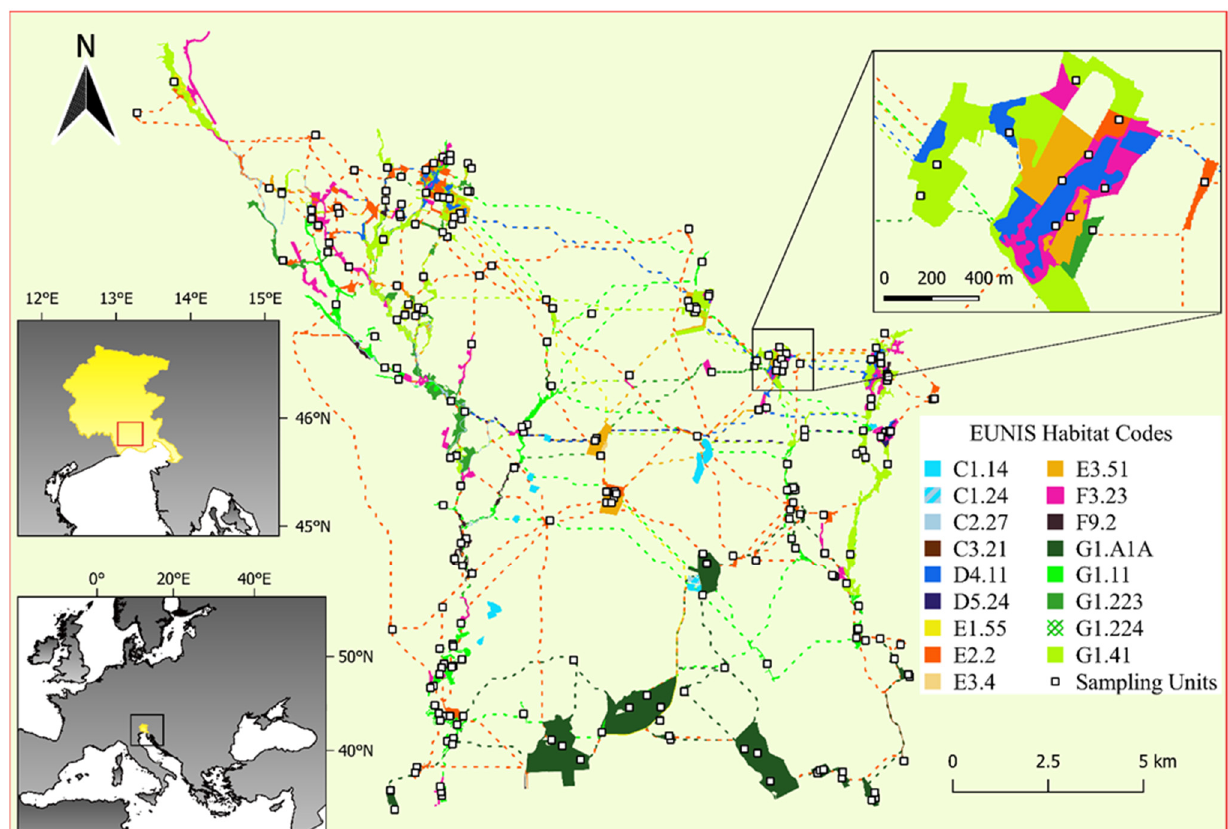
Figure 1. Study area location (Friuli Venezia Giulia region is represented in yellow) and ecological network representation (all the nodes of the EN are shown, including aquatic and smaller than 1 ha nodes). EUNIS Habitat Codes are as follows: C1.14 Charophyte submerged carpets in oligotrophic water bodies; C1.24 Rooted floating vegetation of mesotrophic water bodies; C2.27 Mesotrophic vegetation of fast flowing streams; C3.21 Phragmites australis beds; D4.11 Schoenus nigricans fens; D5.24 Fen Cladium mariscus beds; E1.55 Eastern sub-Mediterranean dry grassland; E2.2 Low and medium altitude hay meadows; E3.4 Moist or wet eutrophic and mesotrophic grassland; E3.51 Molinia caerulea meadows and related communities; F3.23 Tyrrhenian sub-Mediterranean deciduous thickets; F9.2 Salix carr and fen scrub; G1.A1A Illyrian Quercus-Carpinus betulus forests; G1.11 Riverine Salix woodland; G1.223 Southeast European Fraxinus - Quercus - Alnus forests; G1.224 Po Quercus - Fraxinus - Alnus forests; G1.41 Alnus swamp woods not on acid peat. Colored lines and patches are corridors and nodes of the network, representing different habitat types and species-specific networks. An example of the hierarchical sampling design in which each node was sampled stratified by habitat type proportionally to habitat extent within the node is showed.